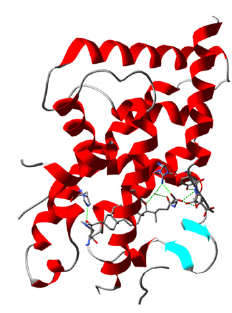
Figure 5. Crystal structure of the complex of VDR LBD with 7b . ( a ) Overall structure, and ( b ) binding to the VDR, compared with ( c ) that of 3 ( Dcha-20 ) (PDB: 7C7V) [9].